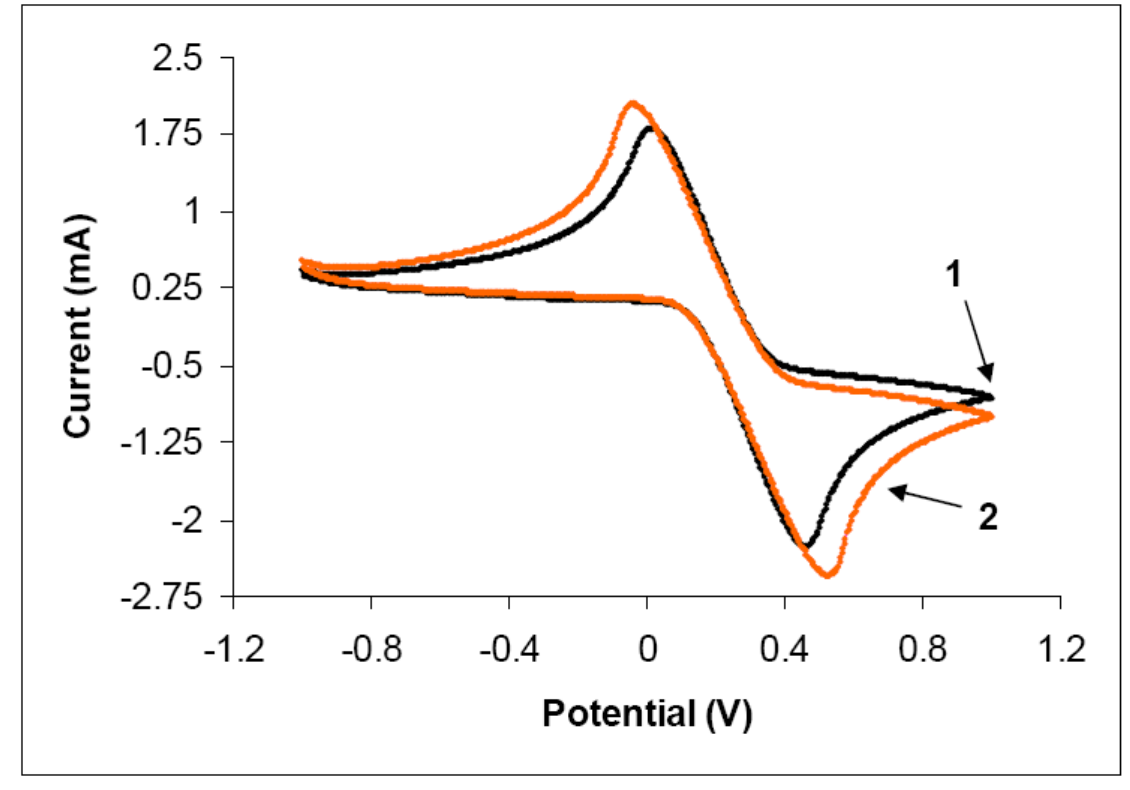
Figure 6. Cyclic voltammogram of 5 mM potassium ferrocyanide and 0.1 M potassium nitrate without theophylline (1) and with 5 mM theophylline (2) on untreated